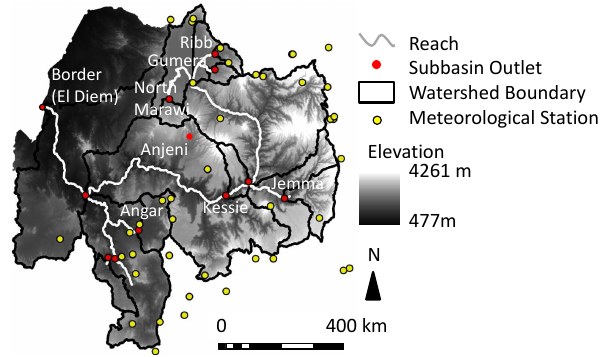
Fig. 1. Digital Elevation Model (DEM), reaches, subbasins and sub- basin outlets initialized in the Blue Nile Basin SWAT model. Also displayed is the distribution of meteorological station used in the model.